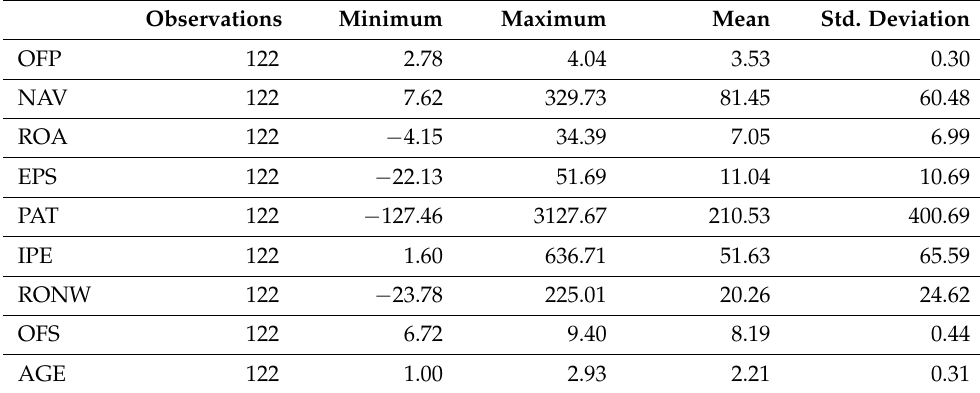
Table 3. Descriptive